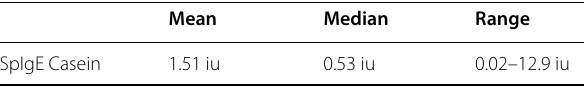
Table 6 Casein values with delayed reaction